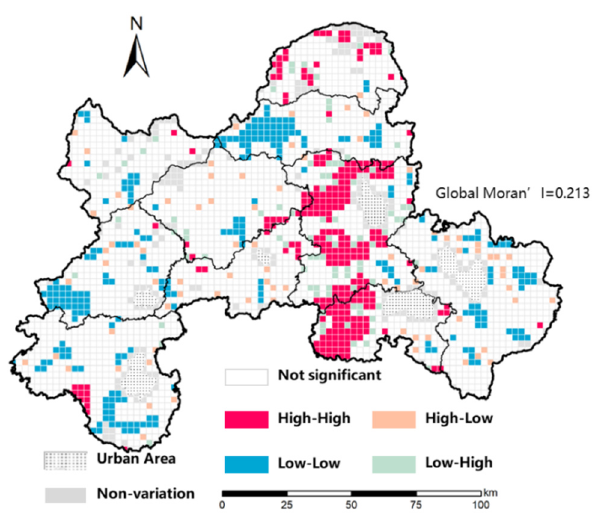
Figure 8. Maps to show significant ( p < 0.05) spatial autocorrelation of matching modes.